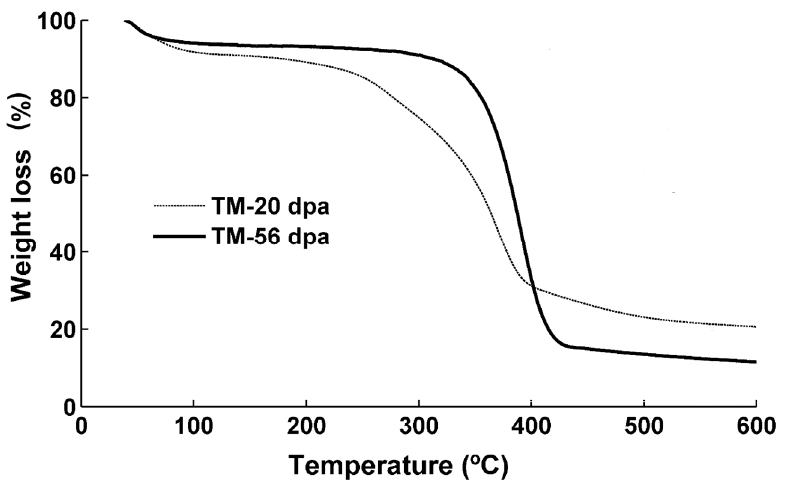
Figure 3. Percentage weight loss of cotton fibers from TM-1 genotype harvested at 20 and 56 dpa as a function of temperature.